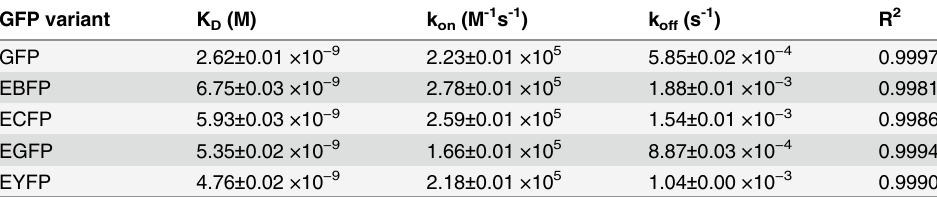
Table 2. Kinetic constants of GFP-ready-TNF α directed toward GFP